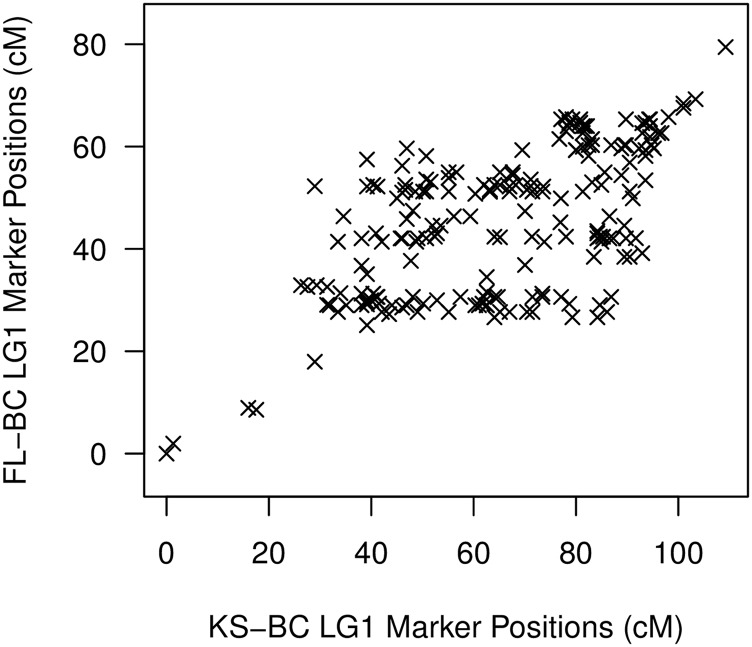
Marker order is not preserved between backcross populations. The genetic positions (in cM) of all markers on linkage group 1 (LG1) that are shared between the FL-BC and KS-BC populations. If relative marker position was consistent between backcrosses, points would appear on a line/curve.